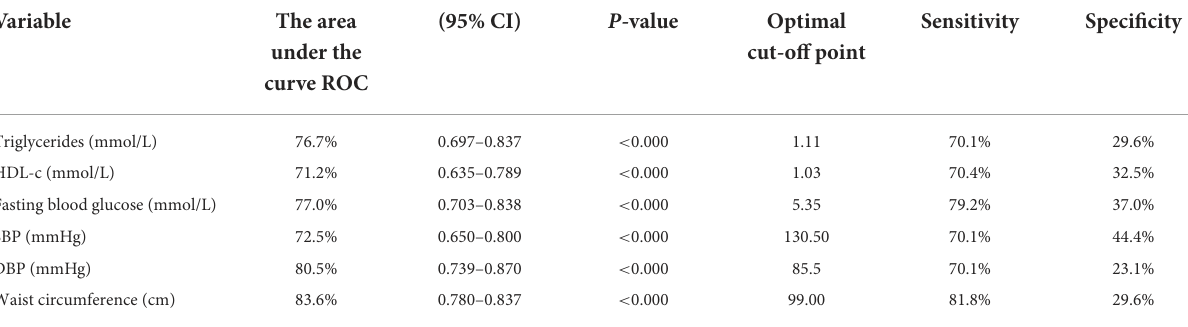
TABLE 5 Optimal cut-off point for components of MetS.